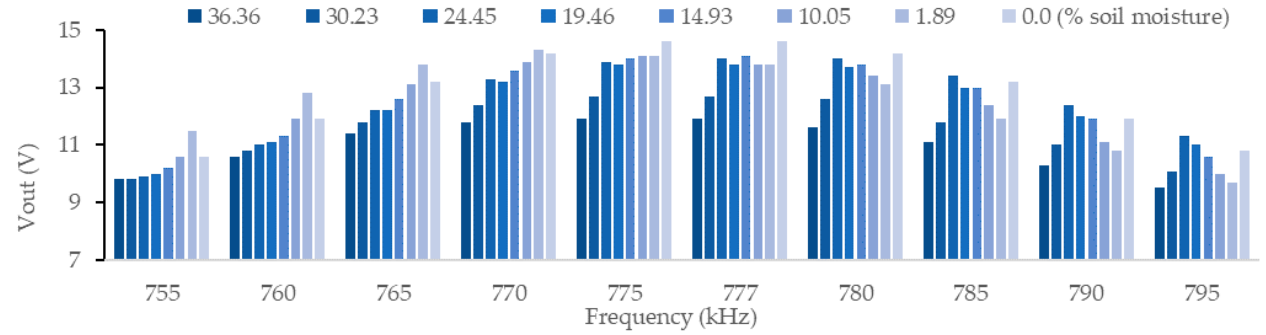
Figure 14. Vout of P8 using S4.